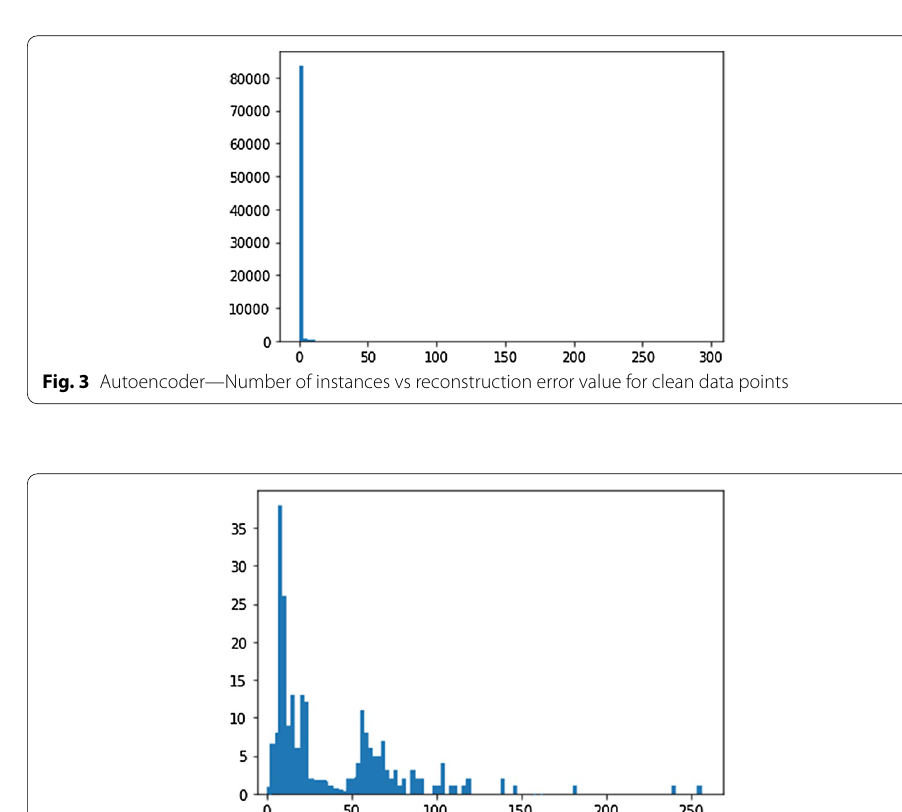
Fig. 4 Autoencoder—Number of instances vs reconstruction error value for noisy data points